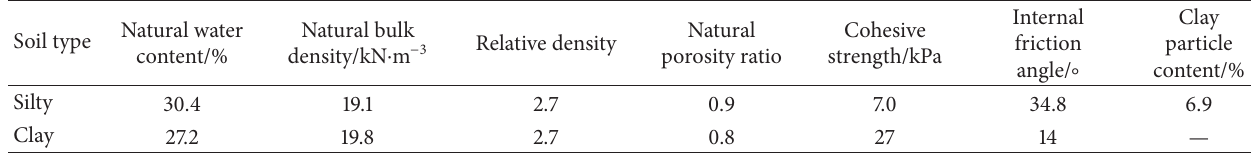
Table 1: Physical and mechanical parameters of the in situ soil.